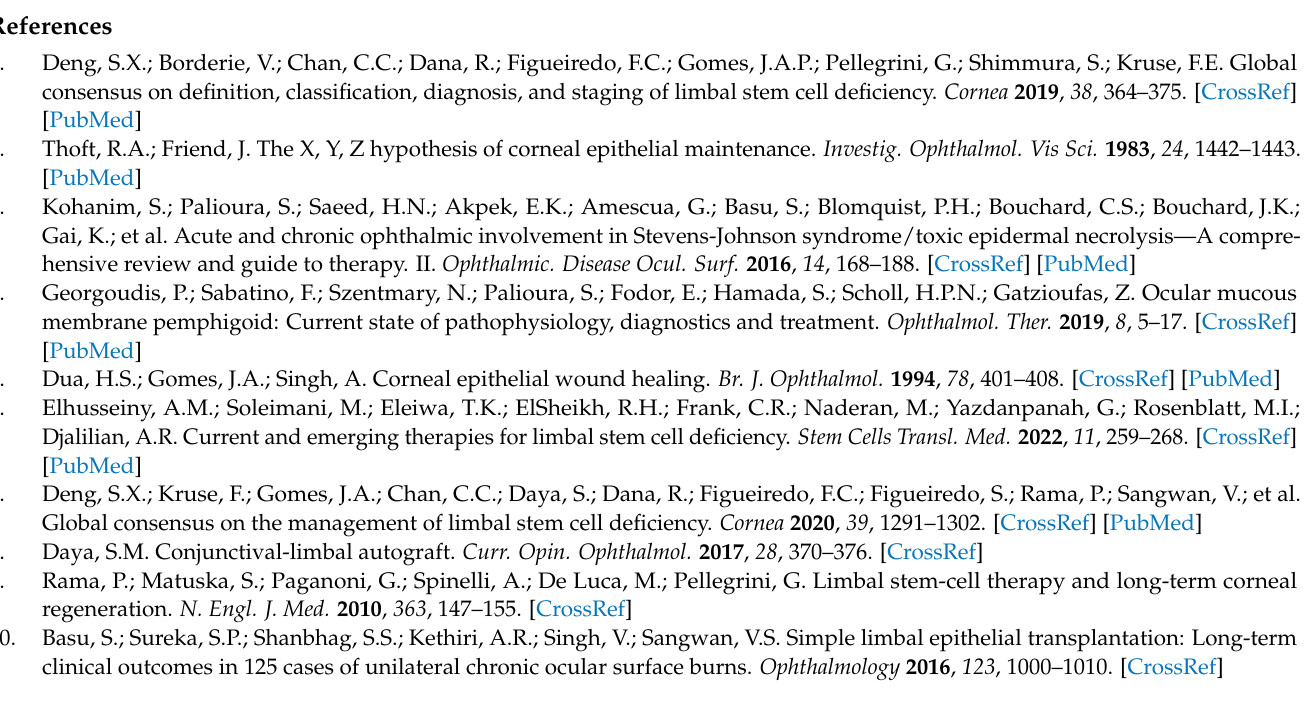
Table S4. Correlation analysis of cytokines 6 months postoperatively (after GSLET) in patients with partial and total LSCD (pg/mL). Table S5. Correlation analysis of cytokines 12 months postoperatively (after GSLET) in patients with partial and total LSCD